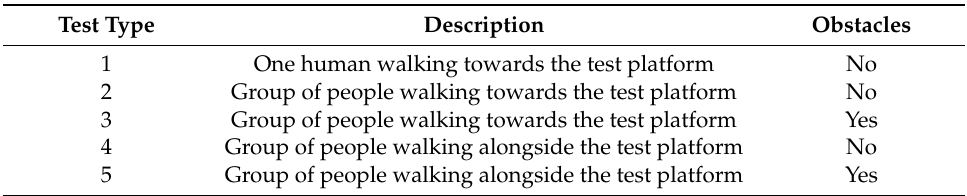
Table 1. Performed experimental